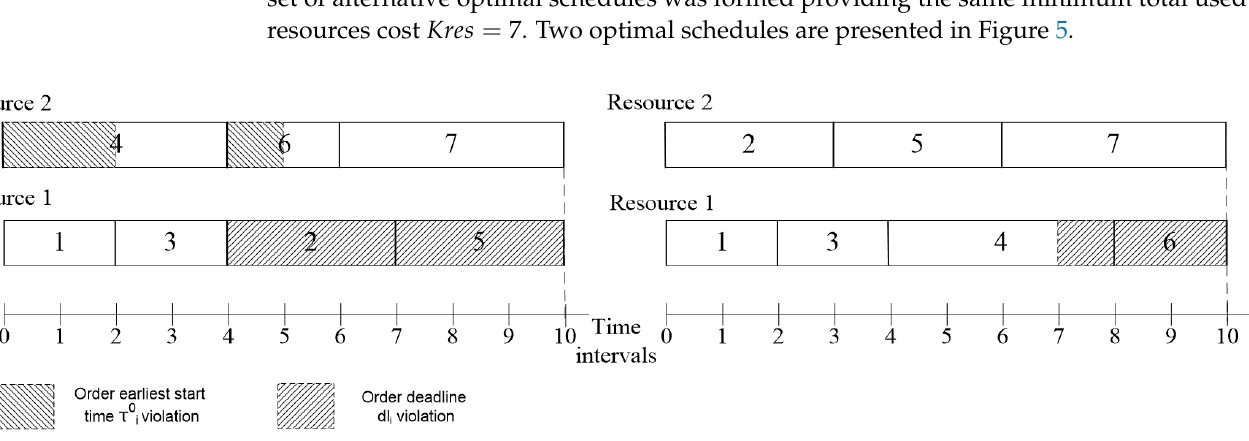
Figure 5. Two optimal schedules provided by the commercial solver.